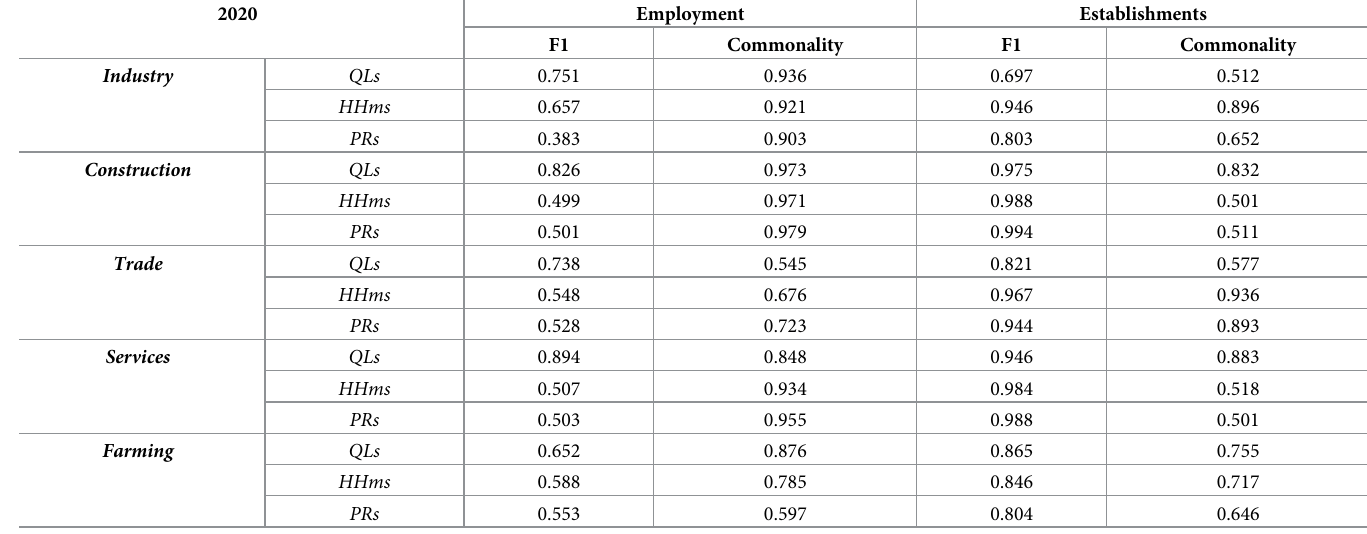
Table 3. Factorial loads after orthogonal rotation and commonalities, obtained in factor analysis, which make up the ICCs , considering the municipalities of Mato Grosso do Sul in the different productive